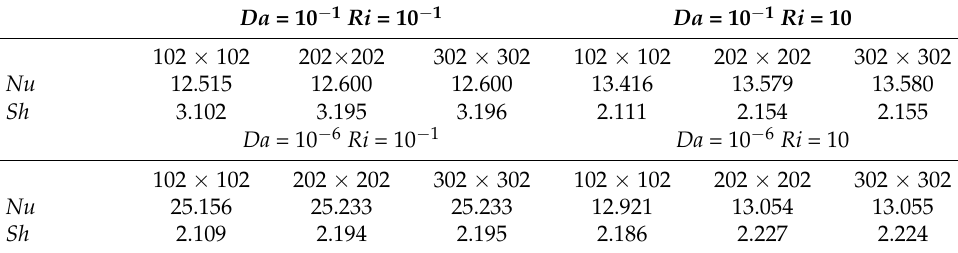
Figure 4. Code validation with Biswas [69] for different porosities at Re = 200, Da = 10 –4 , and Ri = 10.